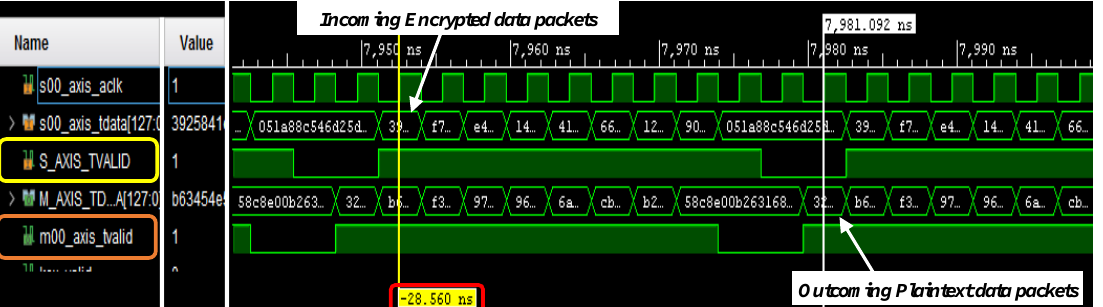
Figure 20. Temporal trends related to the decryption phase; the time interval required to obtain the plaintext data packet from the encrypted data packet is highlighted by time markers applied to s00_axis_tvalid (yellow box) and the m00_axis_tvalid (orange box) signals.